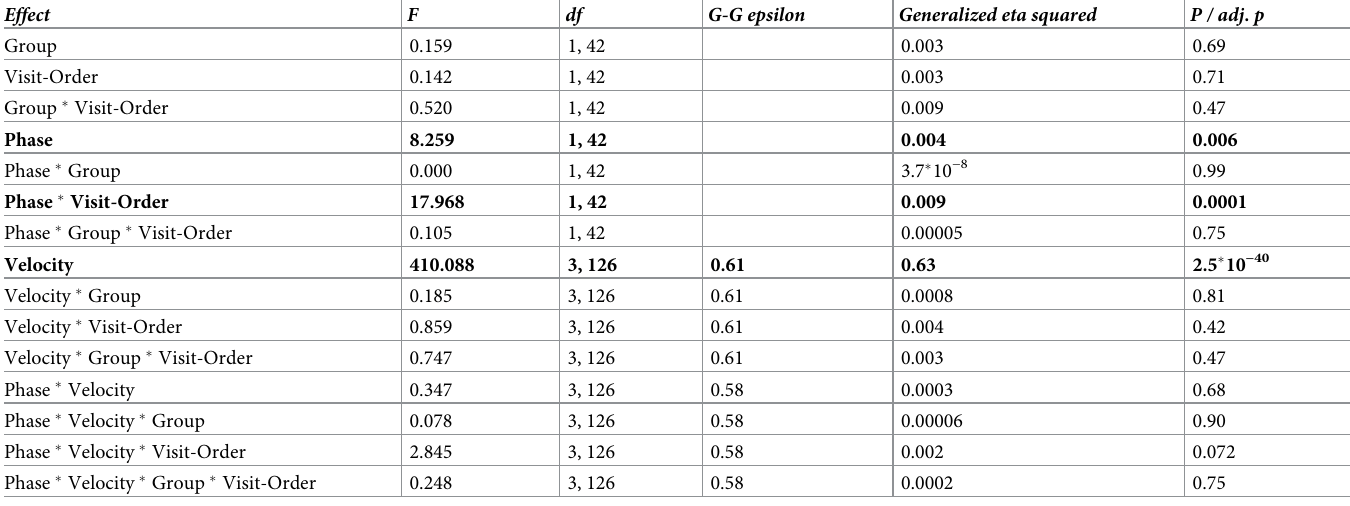
Table 4. ANCOVA results for GR